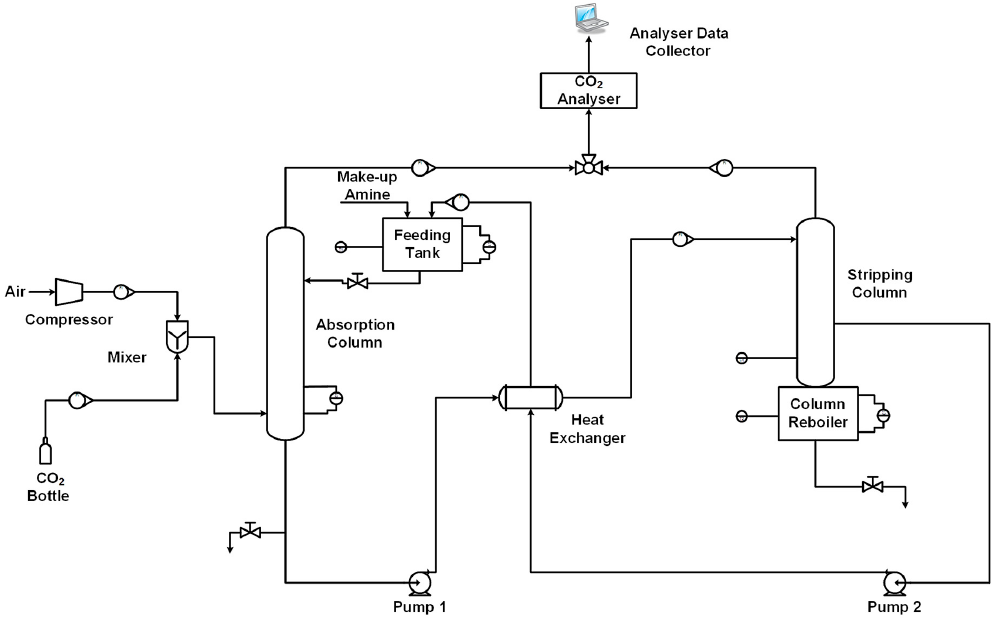
Figure 3. Flowsheet of the pilot units [13].